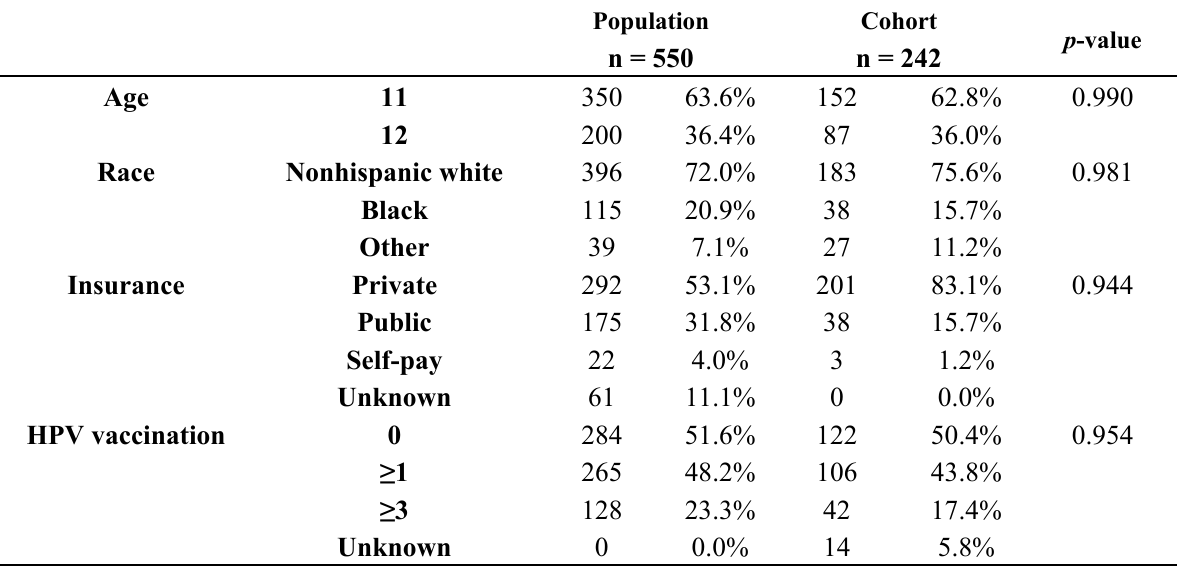
Table 1. Demographics of total population compared to cohort of telephone interview respondents.